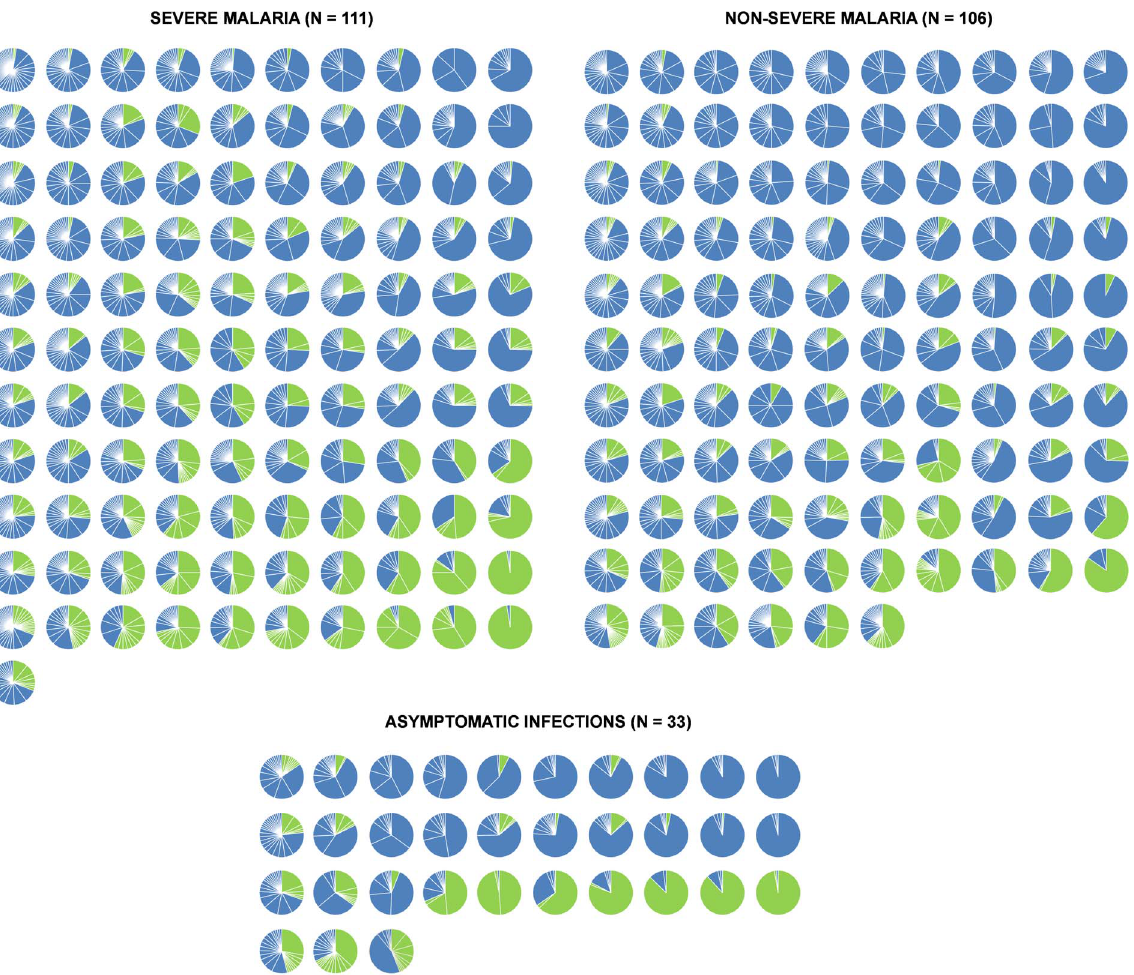
Figure 1. VEH and group A-like var expression levels among isolates from clinical and asymptomatic infections Presented are pie charts summarizing the var expression profiles of all isolates from children with clinical malaria (grouped into severe and non- severe malaria) and those with asymptomatic infection. Each slice of a pie chart (whether blue or green) represents a unique var sequence with green representing group-A like var sequences. The size of the slice represents the percentage contribution of that sequence to the entire var expression profile of the isolate. The pie charts are ordered from left to right by increasing VEH and top to bottom by increasing group-A like var expression levels.